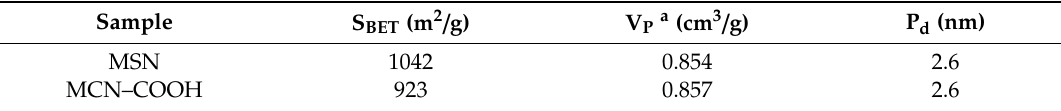
Figure 2. Transmission electron microscope (TEM) image of ( A ) MSN and ( B ) MCN-COOH; ( C ) small angle X-ray scattering (SAXS) pattern of MSN; ( D ) Nitrogen adsorption/desorption isotherms and ( E ) pore size distributions of MSN and MCN-COOH.